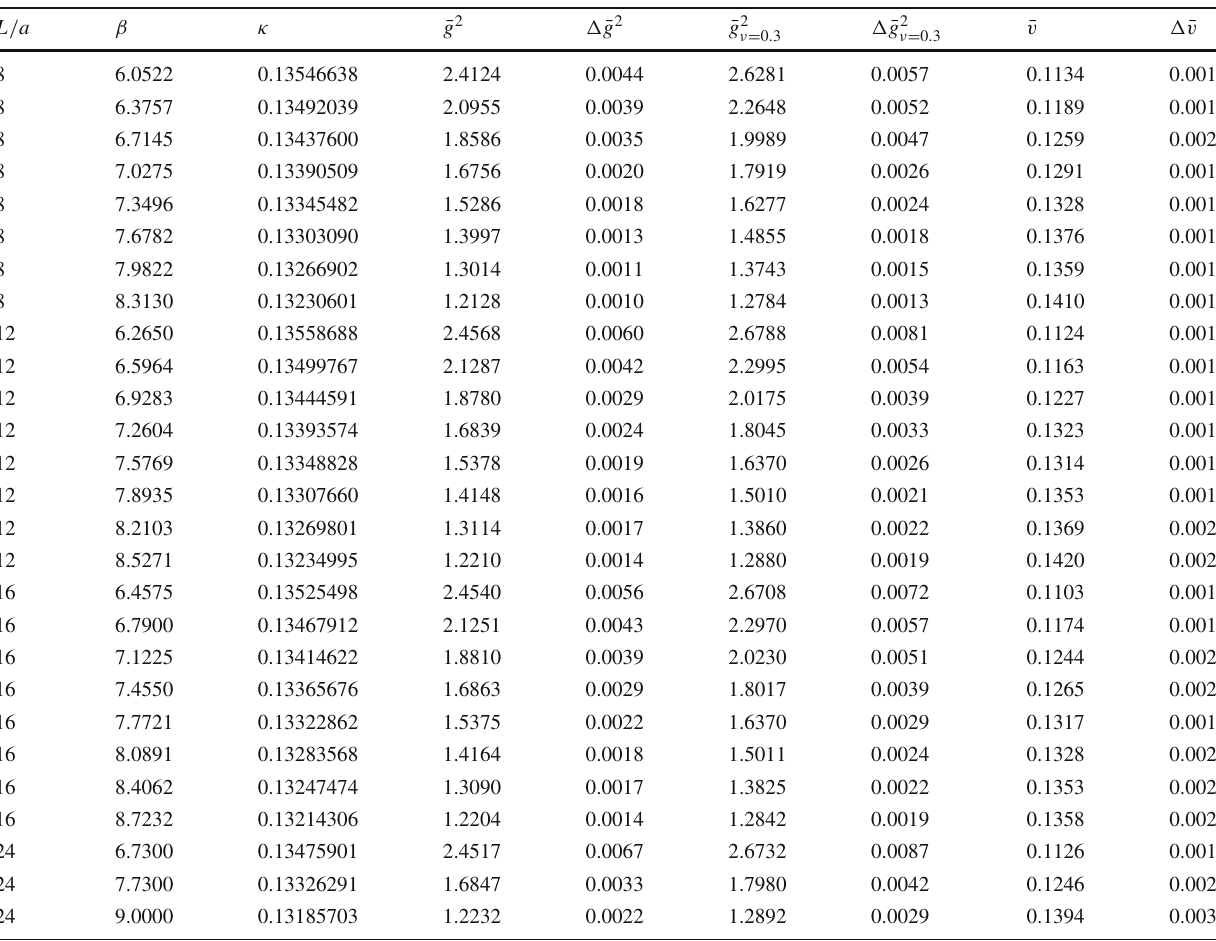
Table 4 Simulation parameters and results on the doubled lattices. The hopping parameter κ was tuned such that the PCAC mass m ( L / 2 ) vanishes, cf. Eq.